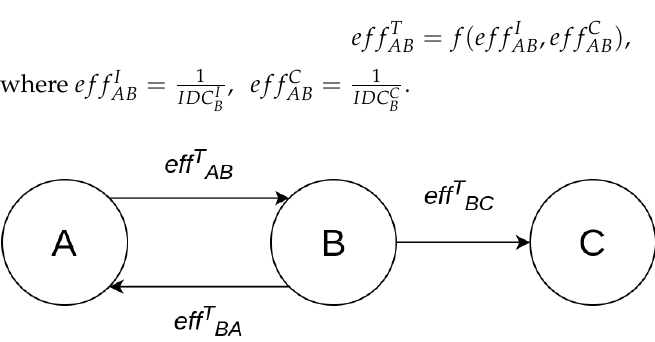
Figure 1. Effect relationship between